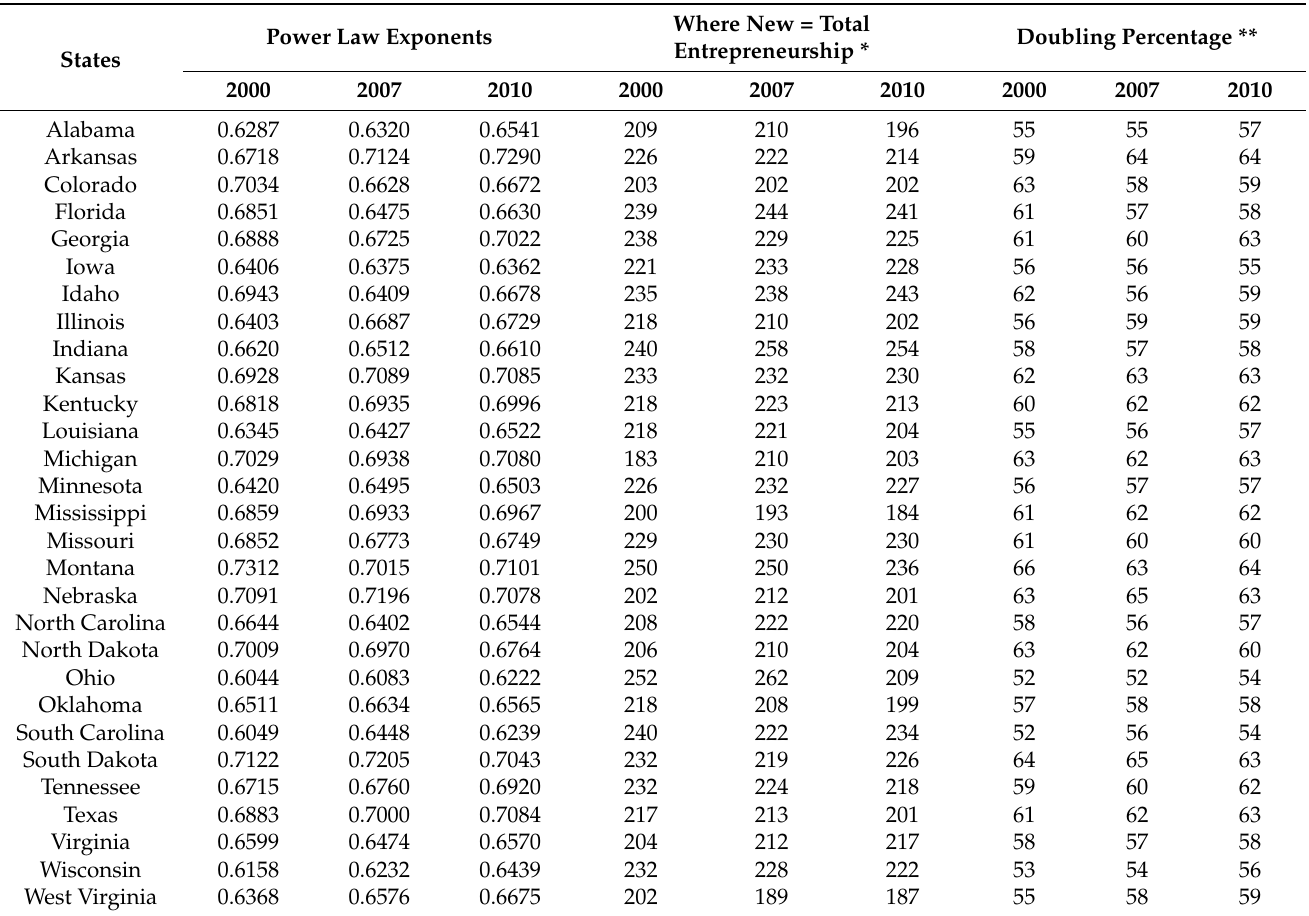
Table 9. Power law characteristics in 2000, 2007, and 2010 of the new entrepreneurship–total en- trepreneurship relationships of county groups of different U.S.